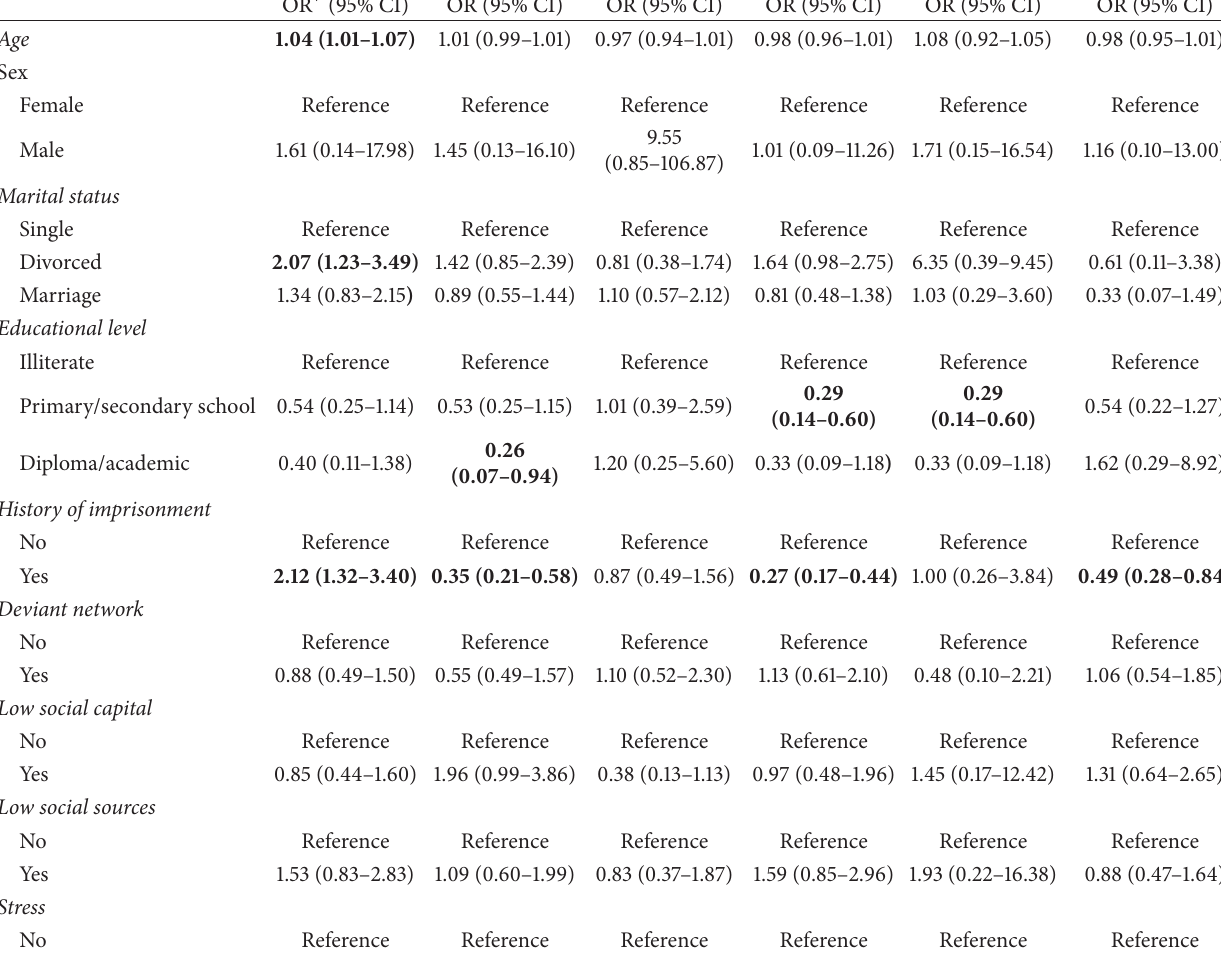
Table 2: Univariate logistic regression for assessing associations between drug use and related factors.